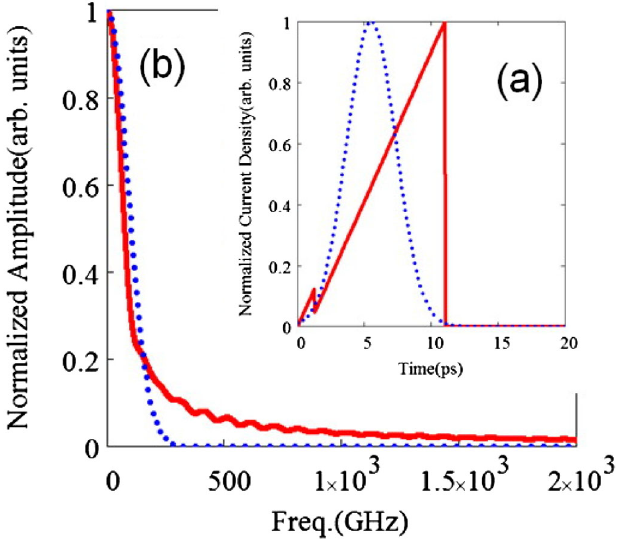
¼ T , where (cid:7) is the bunch t t